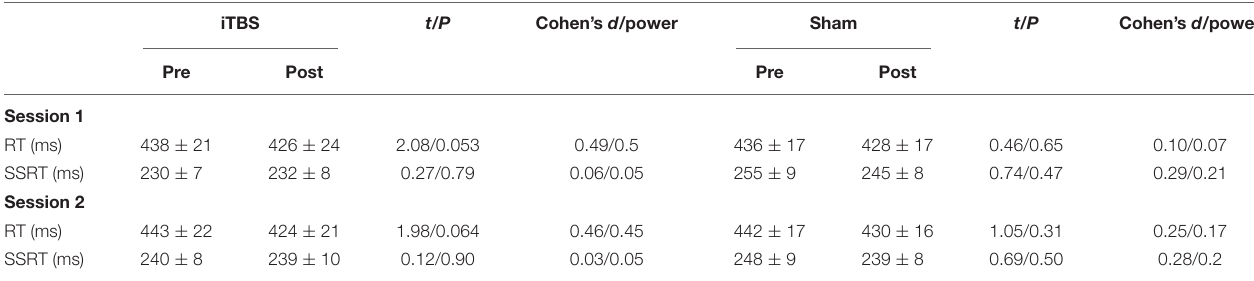
TABLE 2 | Stop signal measures in the second